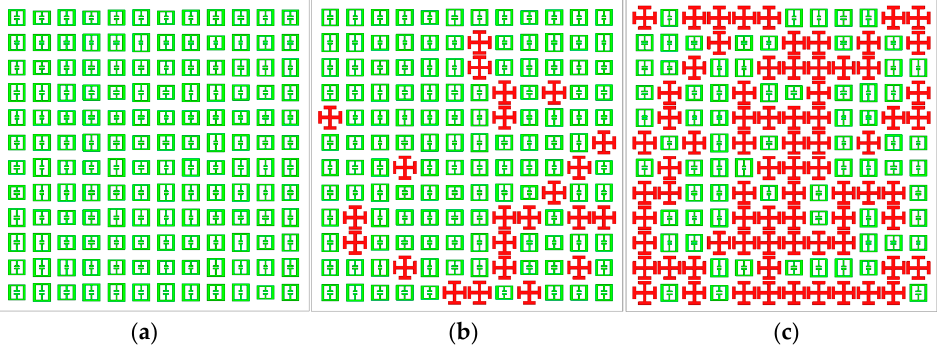
Figure 6. The schematic of simulated metamaterial aperture antenna (MAA) with different ratios of CJC elements: ( a ) 0%; ( b ) 20%; ( c ) 50%.